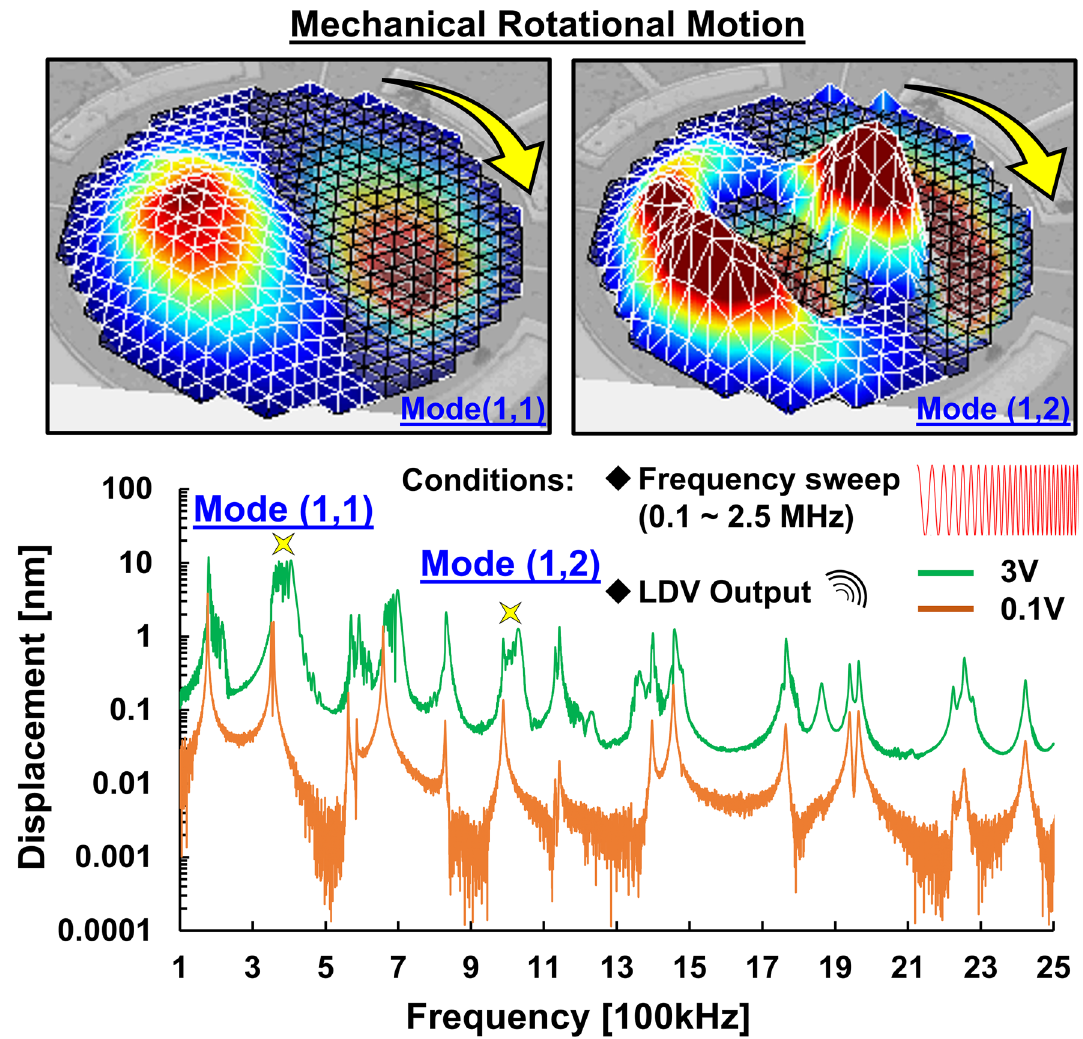
Figure 2. Comparison of the Eigen and rotation motions characterized by LDV measurement: Two mechanical rotation motions are observed by an actuated chirp signal (frequency range from 0.1 to 2.5 MHz) with a sufficiently high voltage of 3 V to drive the resonator into a strong nonlinear state. The measurement results of different linear and nonlinear states are presented for